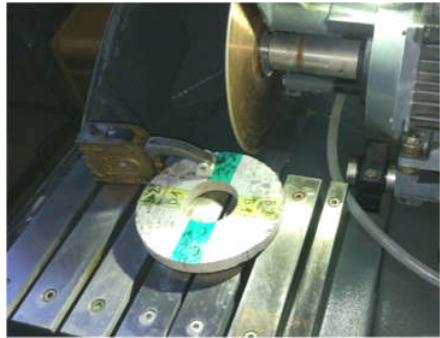
Figure 4. The slice mounted in the chamber of precision saw.